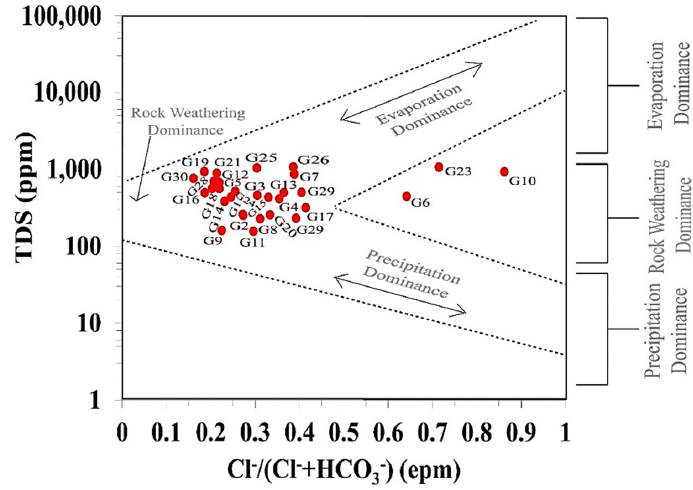
Figure 6. Gibbs diagram for the groundwater samples.